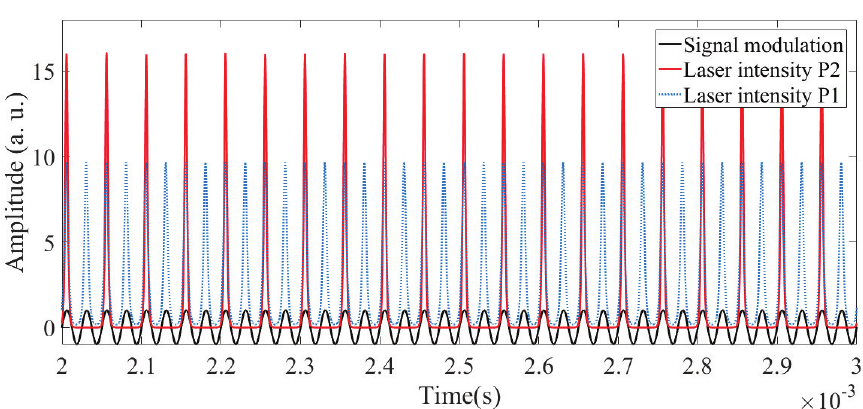
Figure 3. Dynamic response of the EDFL in a regimen of P 2 to a modulation of f m = 40 kHz (red line). The blue line denotes the behavior of the EDFL in period one. The modulation signal is shown in